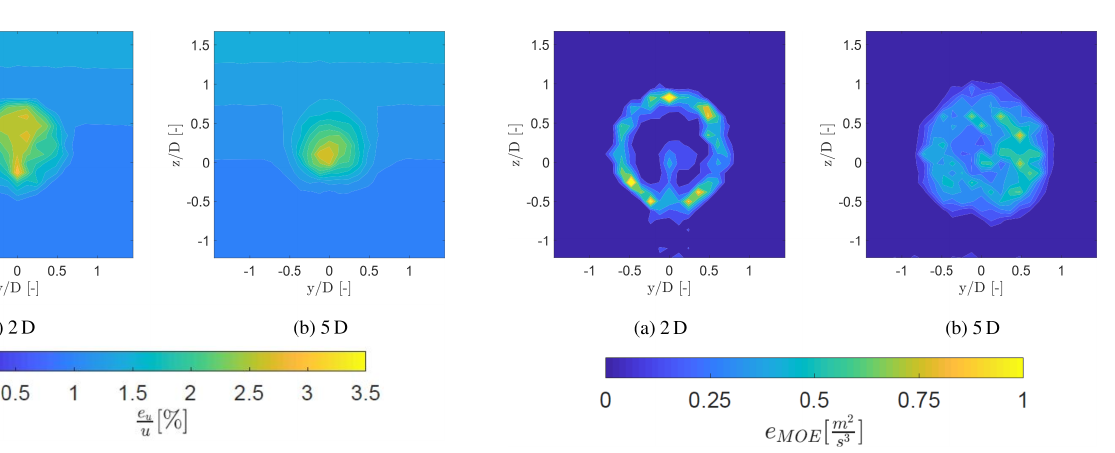
Figure 19. Margin of error ( e MOE ) of the energy dissipation rate at 2 and 5 D for the inflow without a